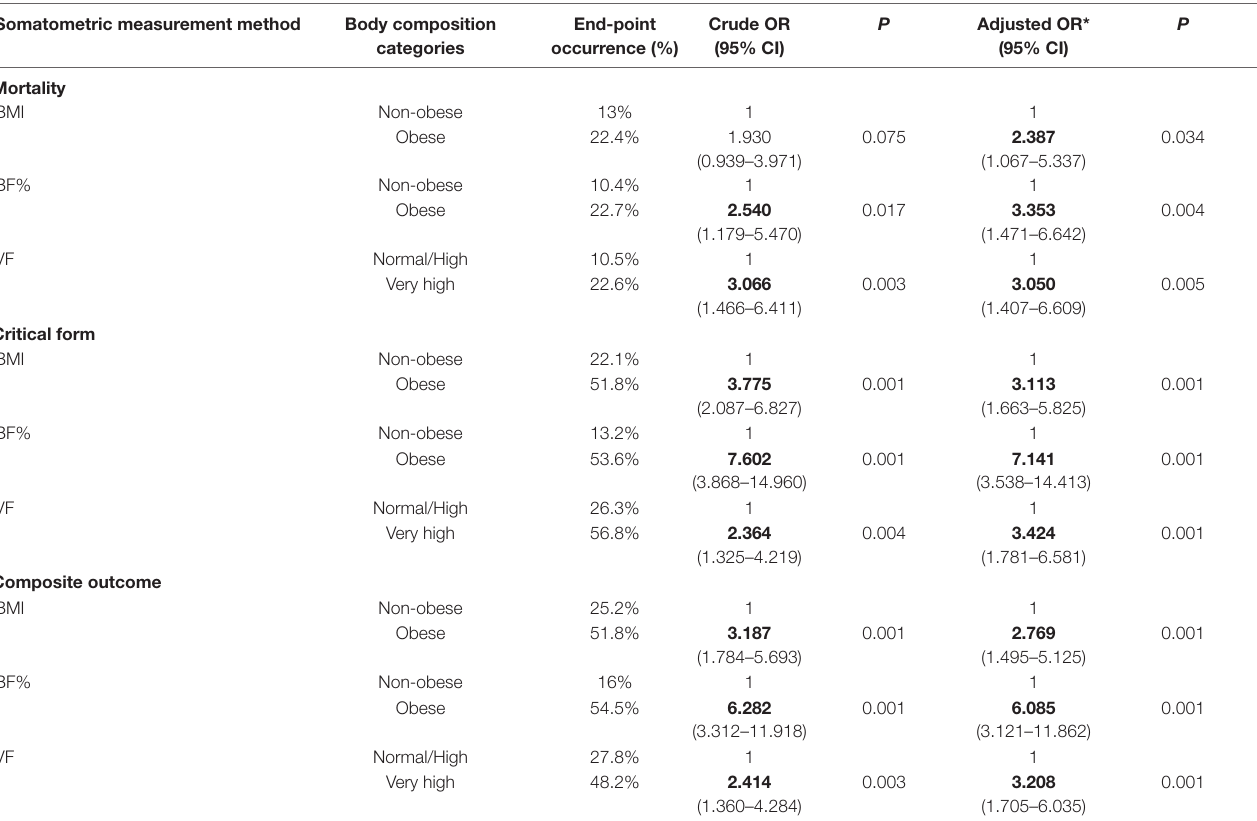
TABLE 3 | Crude and adjusted OR (with 95% CI and “ p ” values) for different somatometric measurement methods in regard to primary end-points occurrence (mortality, ICU admission, and either primary end-point). Somatometric measurement